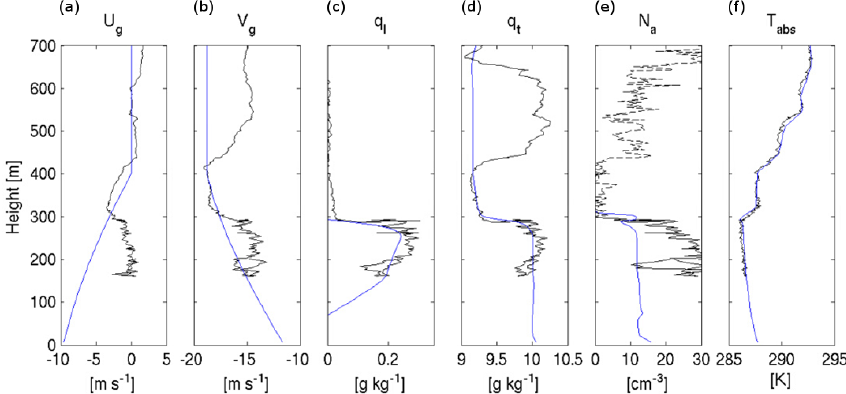
Figure 2. Background profiles of the wind components u and v , liquid water mixing ratio q l , total water mixing ratio q t , absolute temperature T abs , and total aerosol number concentration N a (the sum of cloud droplet number concentration N d , rain droplet number concentration N r , and interstitial aerosol number concentration N ad ) observed by the MRF C-130 prior to sampling the Sanko Peace ship track (black curves). Overlaid are profiles of the forced geostrophic wind components U g and V g , as well as the initial profiles of q t and T (blue